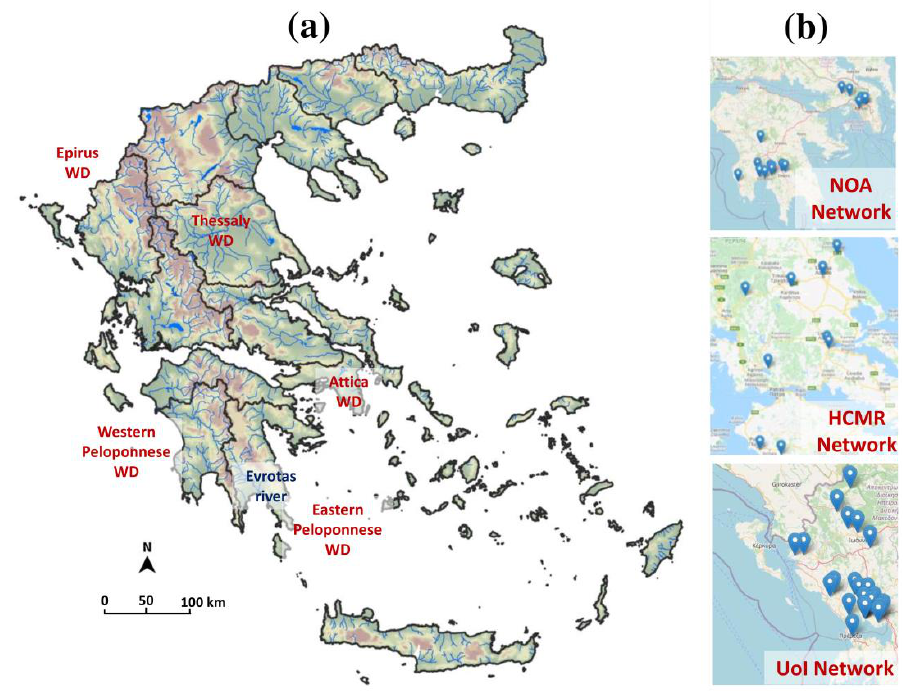
Figure 6. ( a ) Rivers, lakes and water districts of Greece, ( b ) pilot networks of NOA, HCMR, and UnIo.